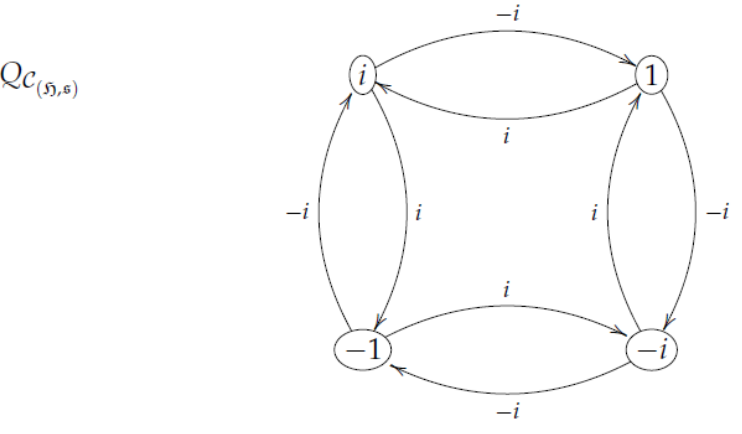
Figure 9. Example of a Cayley graph associated with the 4th unity roots, with s =